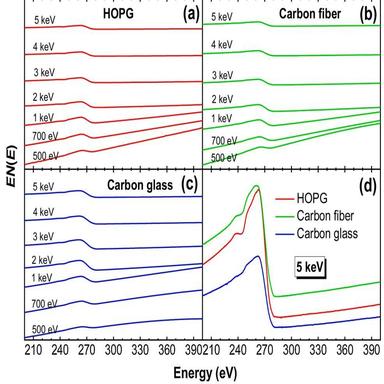
AES spectra for C KVV signals at different primary energies of 500-5000 eV for (a) HOPG, (b) carbon fiber and (c) carbon glass. (d) A comparison on the energy spectra for the three materials at 5 keV.